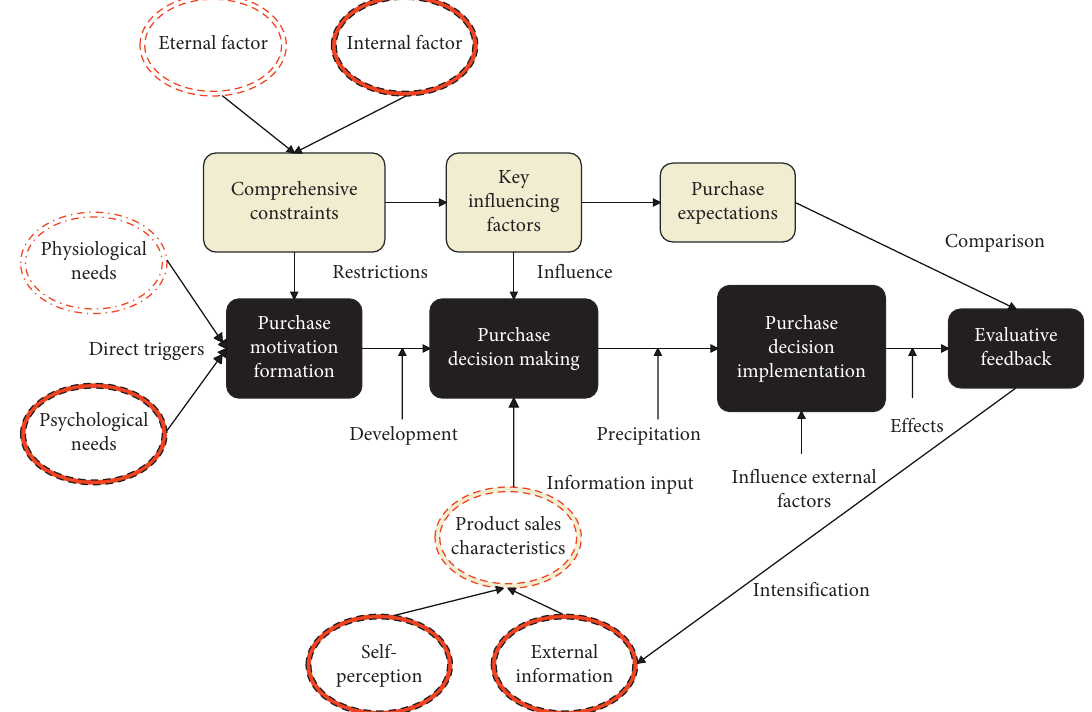
Figure 7: Structure diagram of consumption behavior pattern of fresh agricultural products.